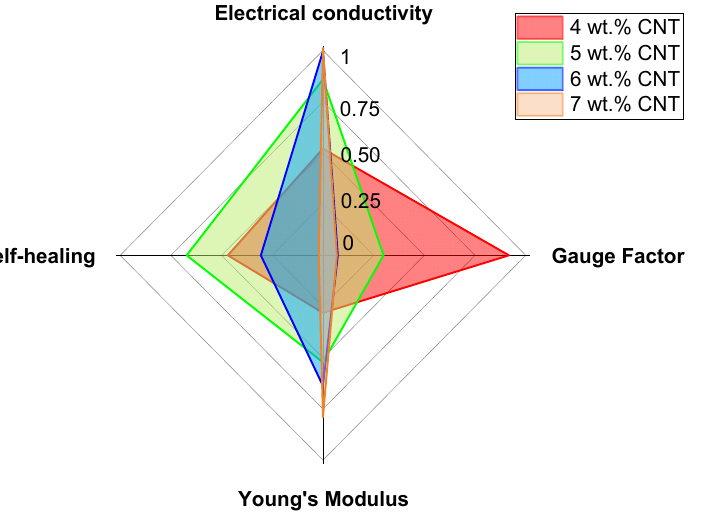
Figure 9. Radar chart of the different CNT–Surlyn nanocomposites to compare their multifunctionality, scaled from 0 to 1.